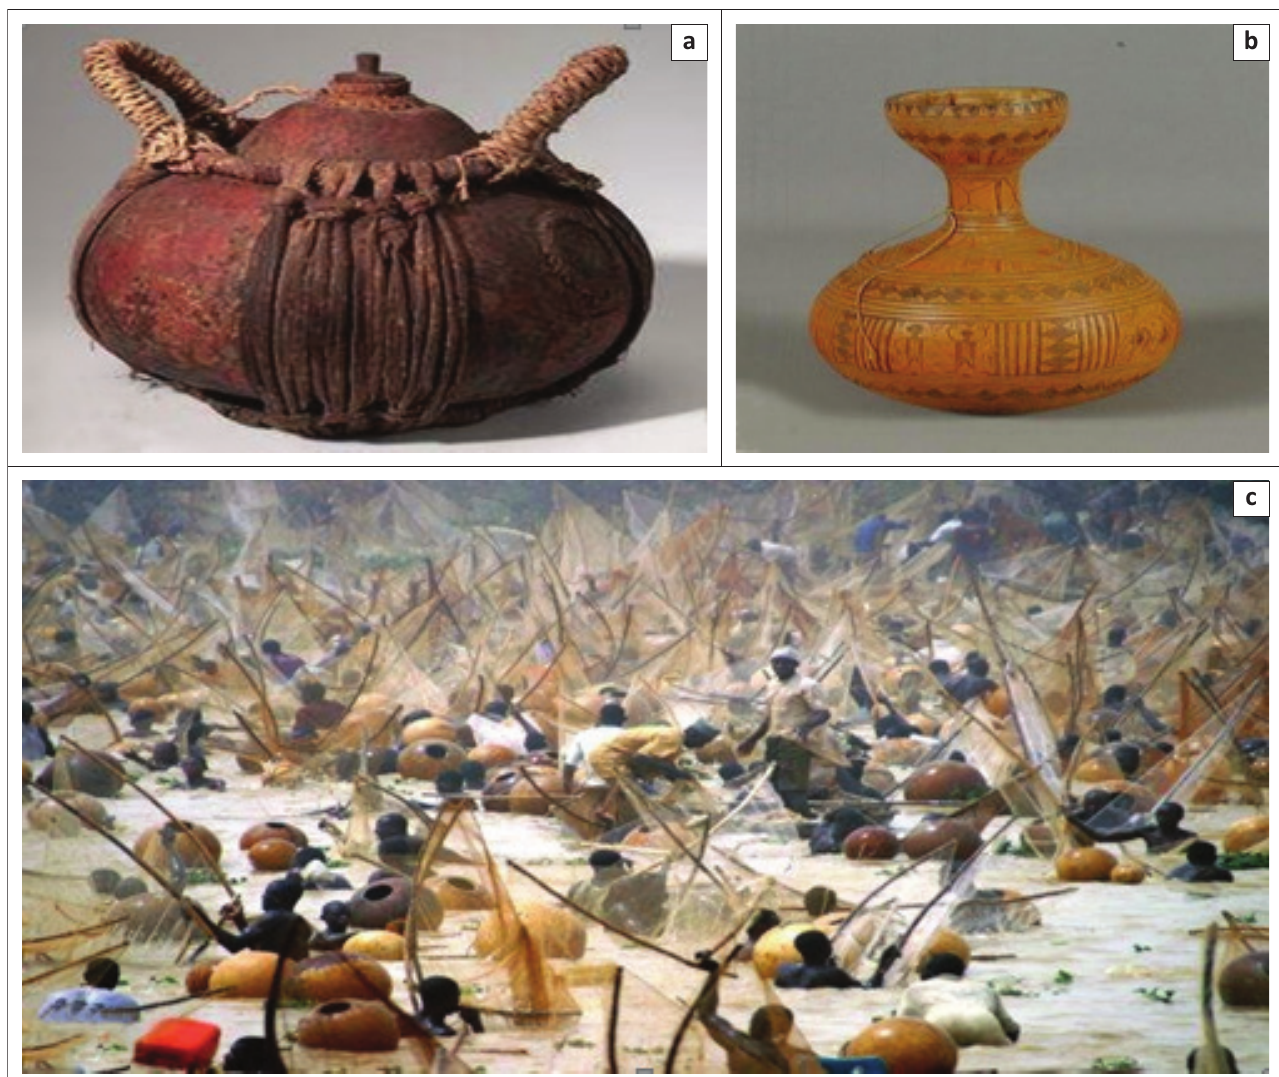
FIGURE 4: Calabash Inkpot (a), Decorated long-necked gourd (b), Gourds used during fishing festival